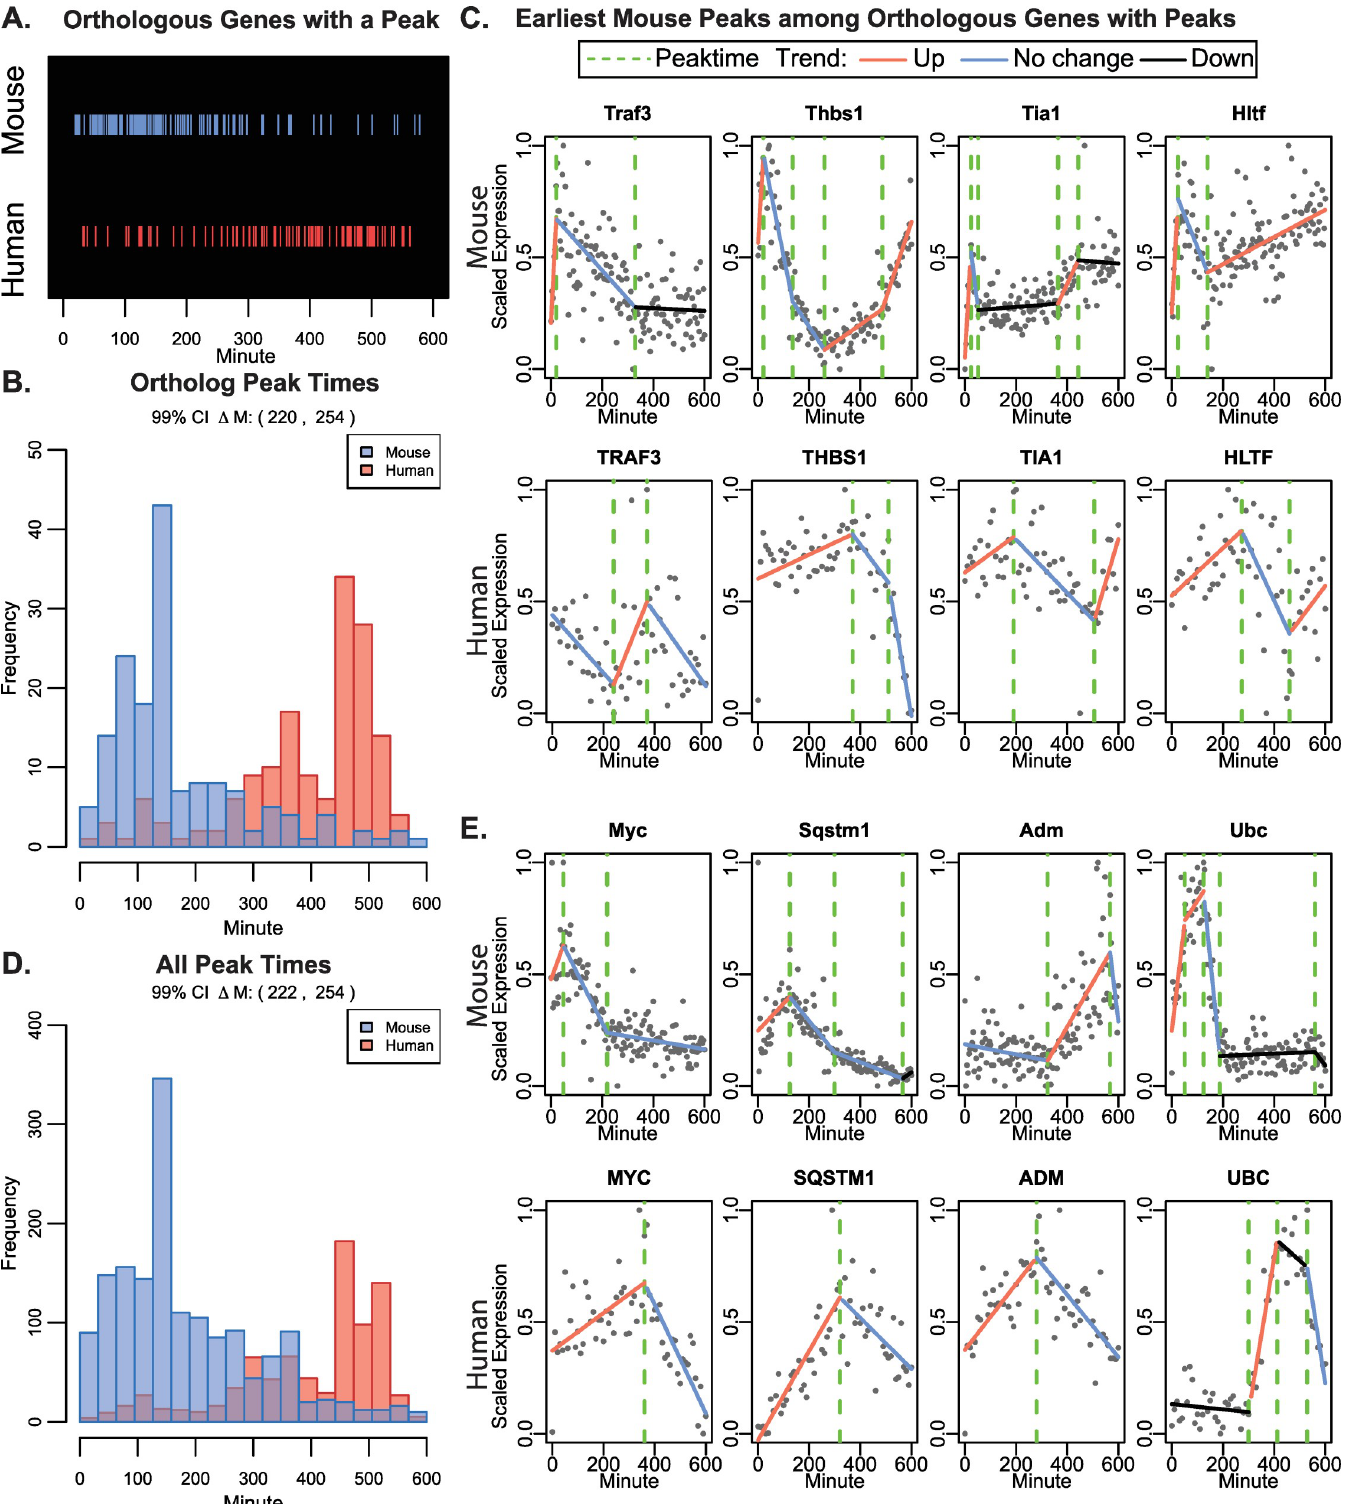
Fig 4. Gene peaks occur earlier in mouse compared to human cells. (A) The sorted peak time of ortholog genes highlighted in either blue or red for mouse and human orthologs, respectively. B) Histogram of the peak time for orthologs. The 99% confidence interval on the paired Wilcoxon rank sum statistic for shift in distribution ( Δ M)